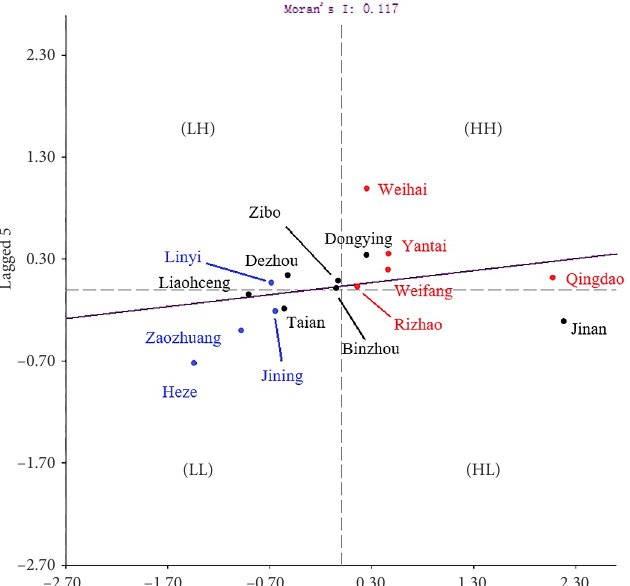
Figure 3. Local Moran index scatter diagram of the construction level distribution of new SCC in Shandong Province in